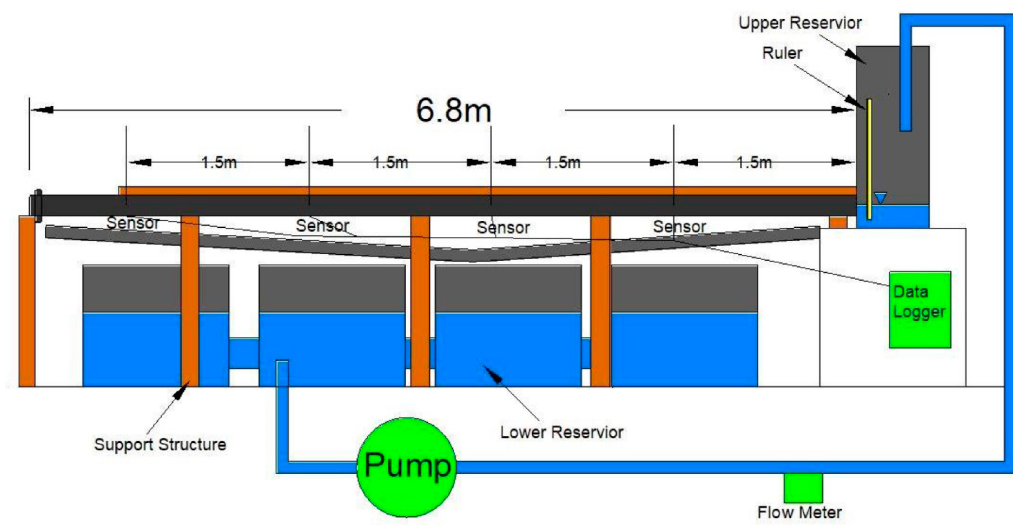
Figure 6. Schematic layout of the exfiltration pipe experimental apparatus.